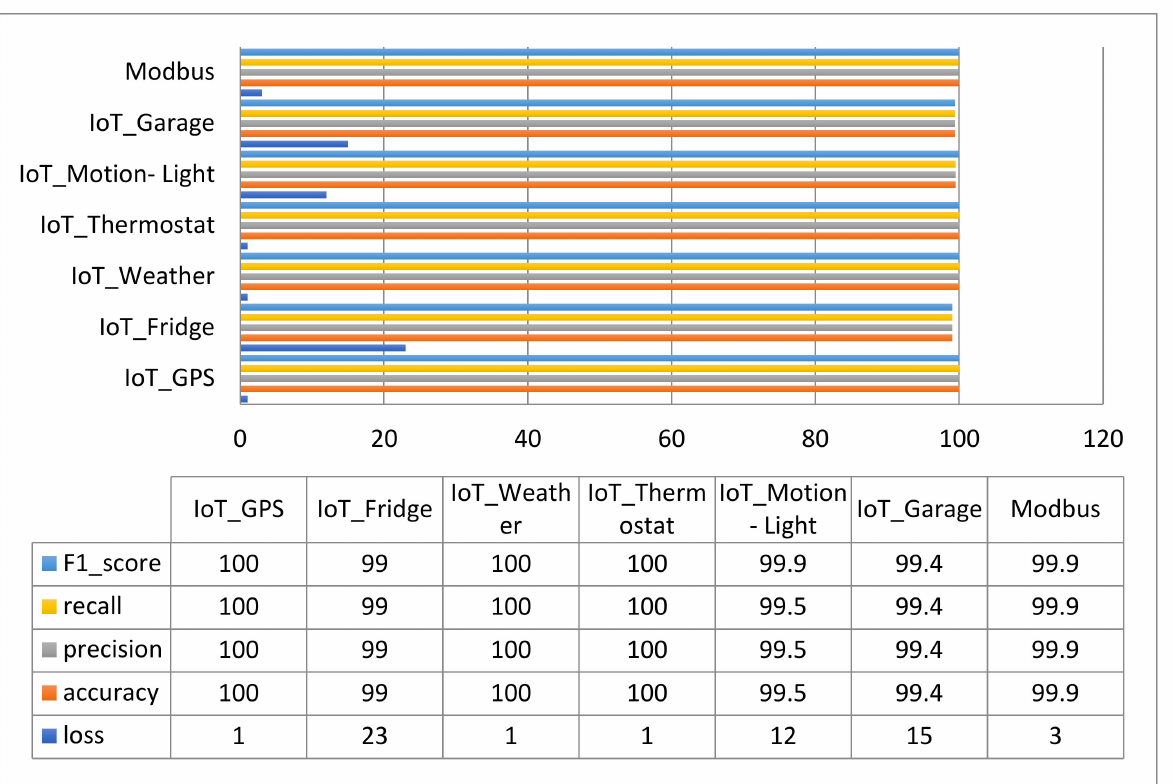
Figure 9. The results of the IoT network in the inception time model of the ToN-IoT dataset. Experiments on the ToN-IoT database showed that the Inception Time model method outperformed DenseNet. The best accuracy we obtained using DenseNet was 99.9%